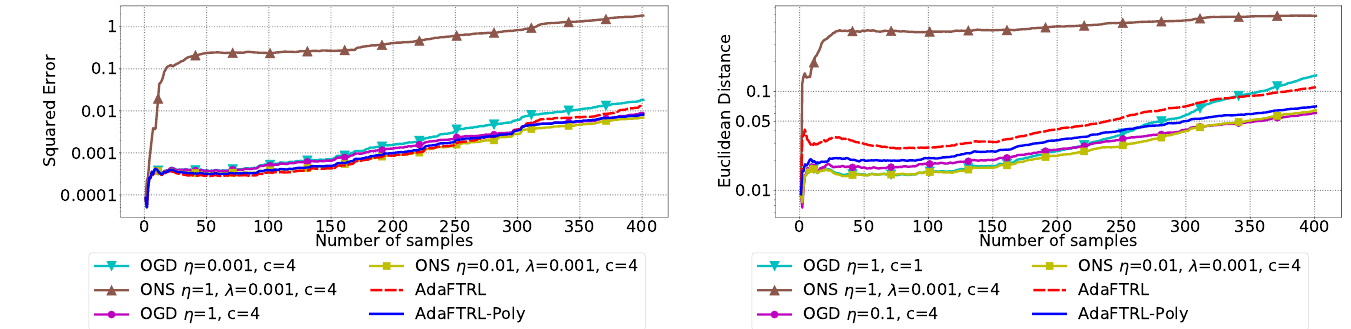
Figure 6. Results for electricity demand